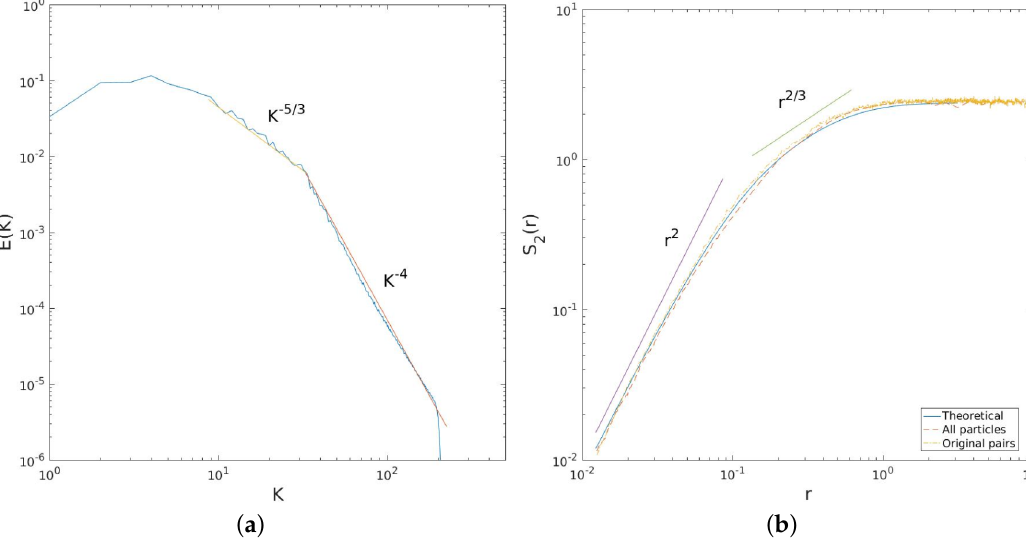
Figure 5. Kinetic energy spectrum (( a ) panel) from the turbulence simulation, reproduced from Figure 9 of [17]. The structure functions (( b ) panel) calculated from the energy spectrum (solid curve), from all particle pairs (dashed red ) and from pairs deployed together (dashed yellow ). The second-order longitudinal structure functions are shown in the right panel of Figure 5. Three curves are plotted. One (blue solid) is that predicted from the energy spectrum using (14). The second (red dashed) was obtained using velocity differences from all particle pairs in the flow. The third (yellow dash-dot) was calculated using velocities only from pairs deployed together, “original pairs” in the terminology of